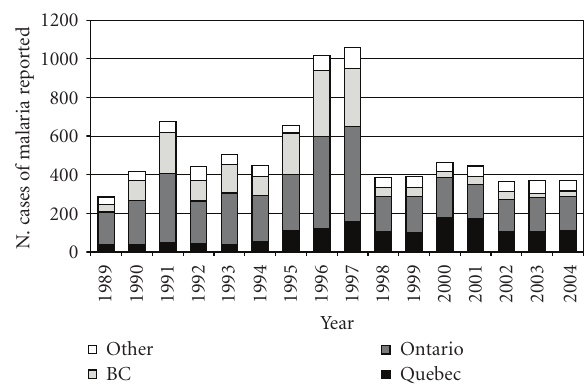
Figure 1: Annual incidence of malaria (caused by all Plasmodium species) in Canada. Data obtained from the Public Health Agency of Canada